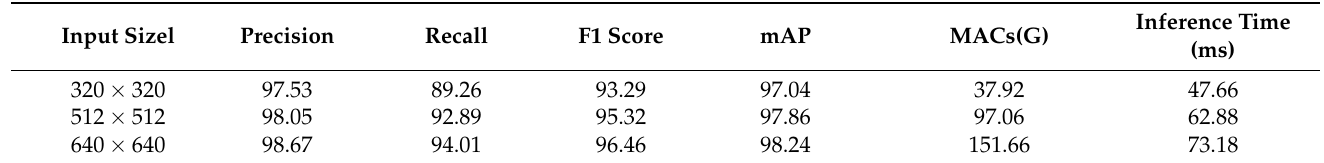
Table 4. Performance of ASPP-YOLOv4 model with different input scales.